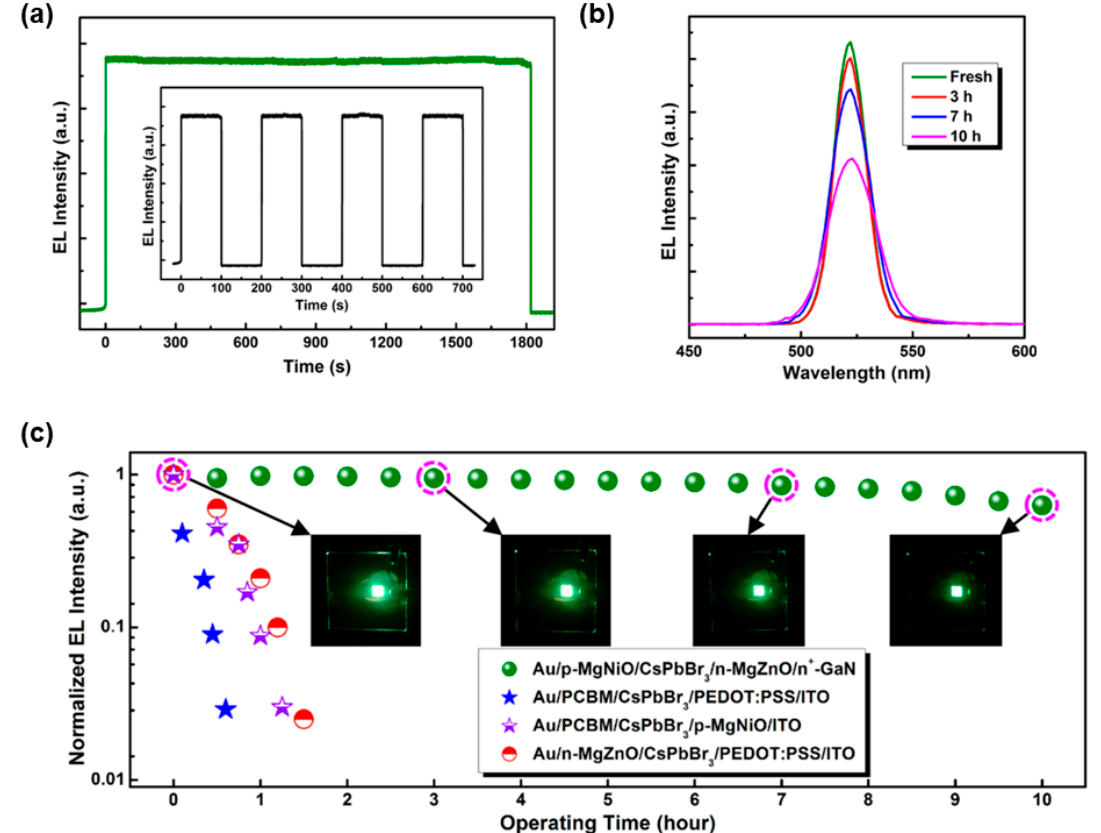
Figure 8. ( a ) Time dependence (30 min) of the room temperature EL intensity of the PeLED under a dc bias of 8.0 V. The inset showed the responses of the EL intensity for four switch-on/switch-off pulses at 8.0 V. ( b ) EL spectra obtained after different running periods. ( c ) PeLEDs as a function of running time (under 10.0 V). The insets showed the corresponding photographs of PeLED after different running periods. Reproduced from reference [211], American Chemical Society, 2017.